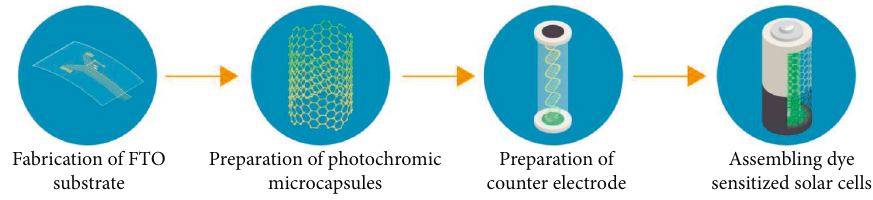
Figure 1: Flow chart of thermal stabilization of solar